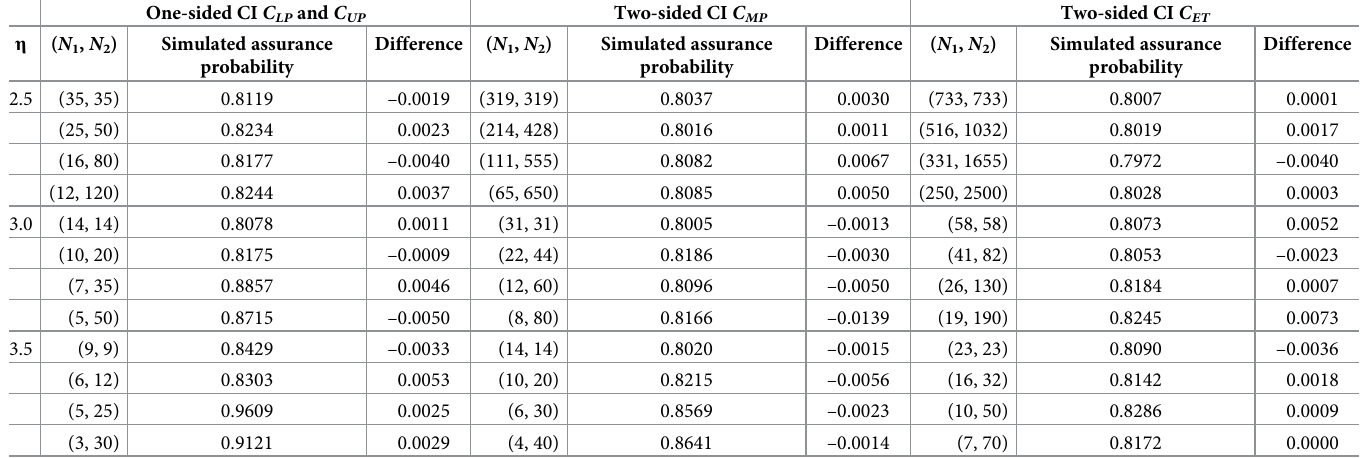
Table 6. The computed sample size, simulated assurance probability and errors for the 95% reference intervals of the distribution proportion 0.90 with assurance probability 0.80. One-sided CI C and C LP UP